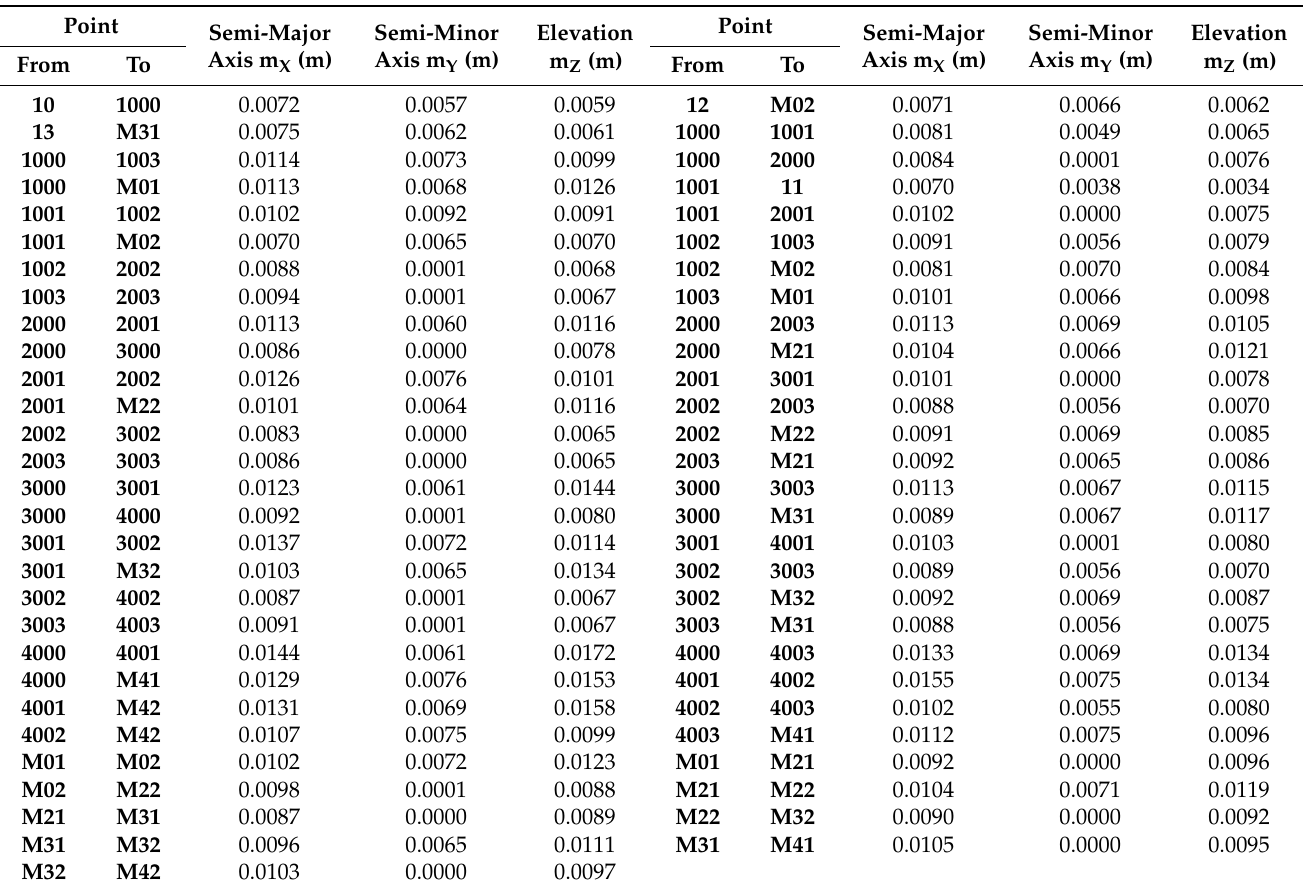
Table A4. The relative accuracy of the point coordinates (95% confidence